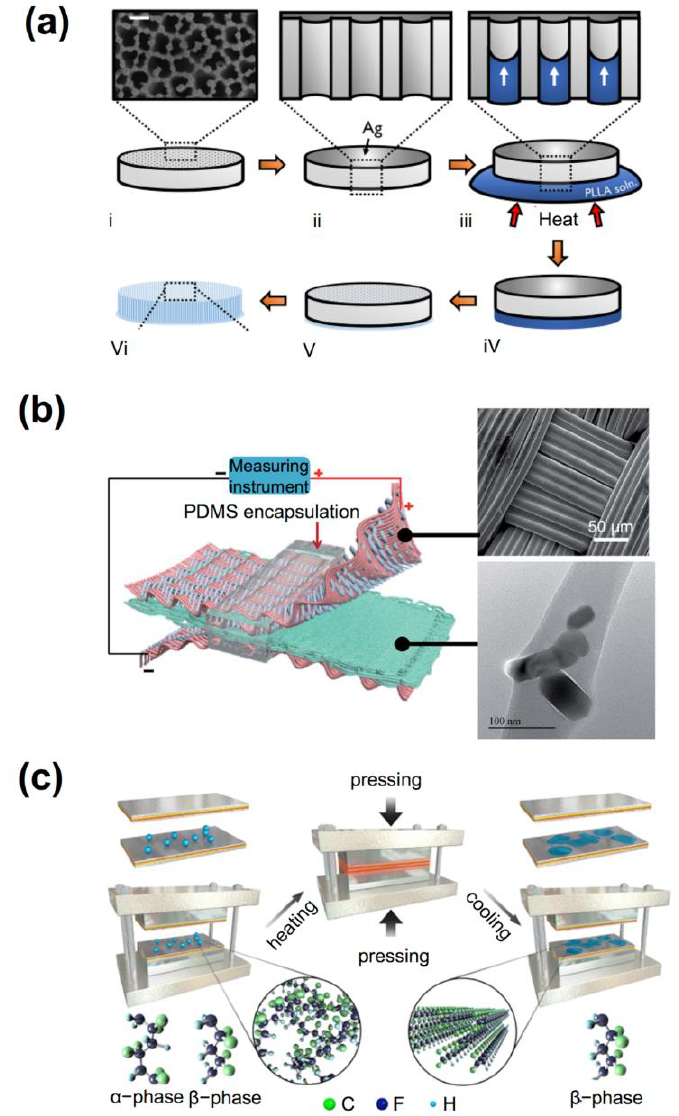
Figure 3. ( a ) A schematic of the temperature controlled capillary infiltration process used to